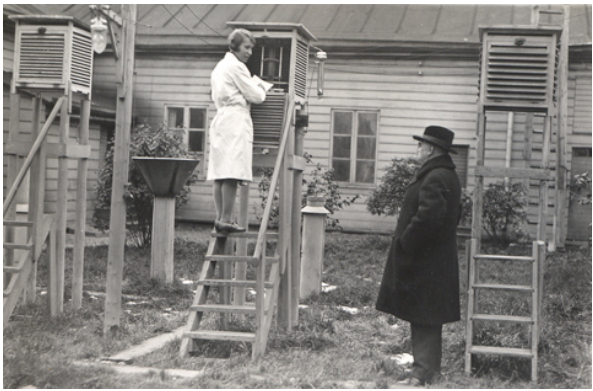
Figure 4. Weather station at the Finnish Meteorological Institute in Helsinki in the 1920s. The man in the right is Gustaf Melander (1861–1938), the director of the Institute 1908–1930 (Photo: